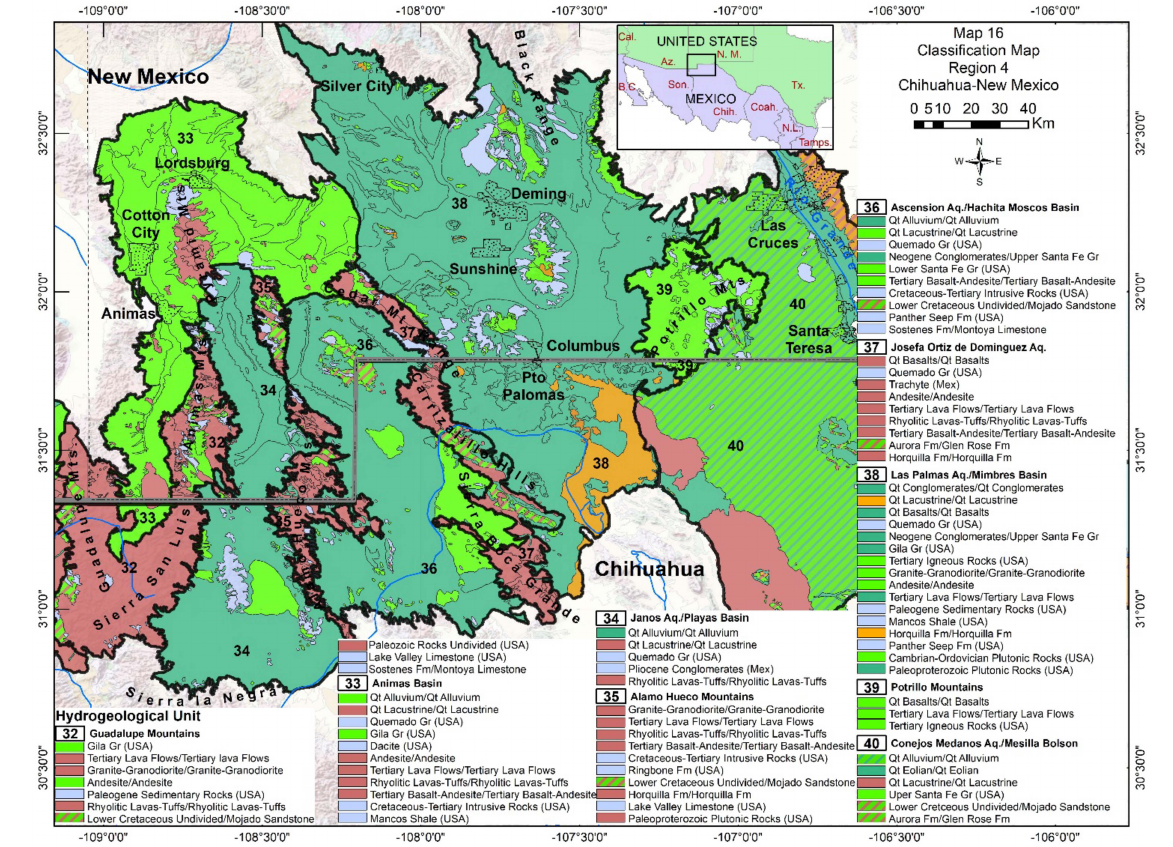
Figure 16. Classification map, Chihuahua—New